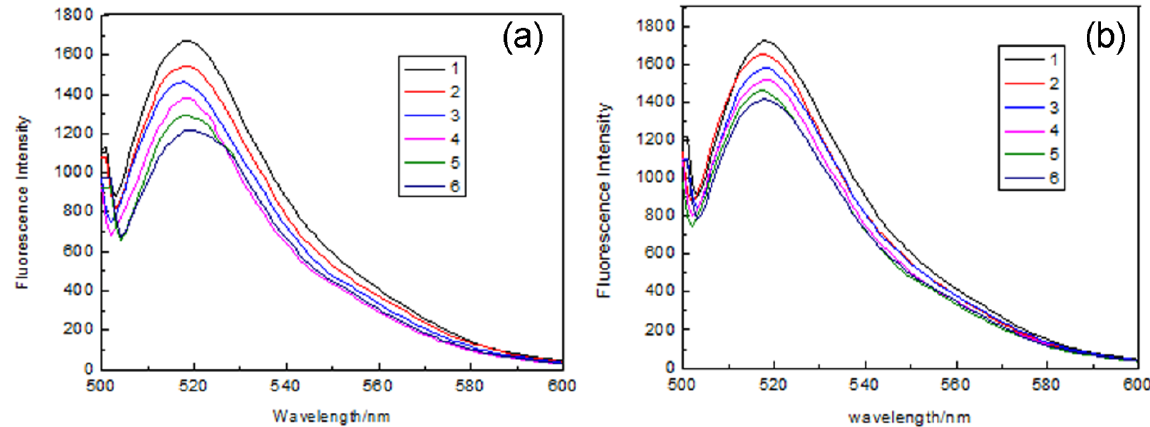
Figure 8. The relationship between F